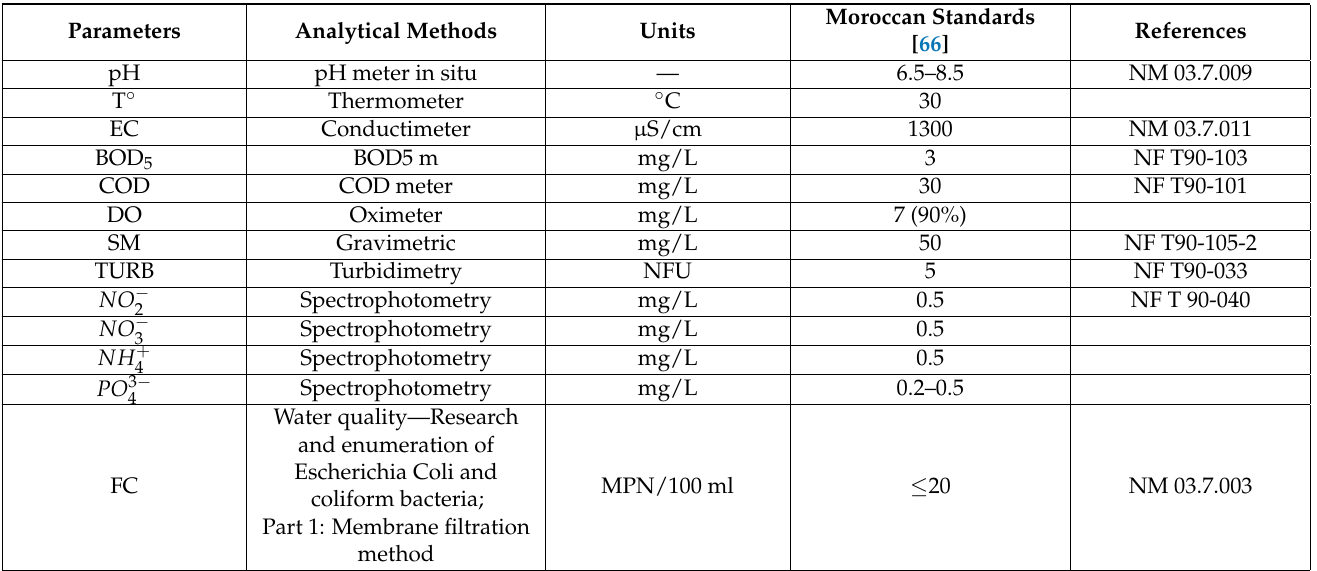
Table 2. The parameters measured, the analytical methods and Moroccan standards used during the analysis, and the interpretation of the